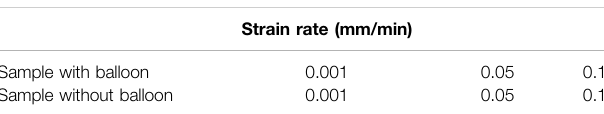
TABLE 1 | Strain rates used for compression